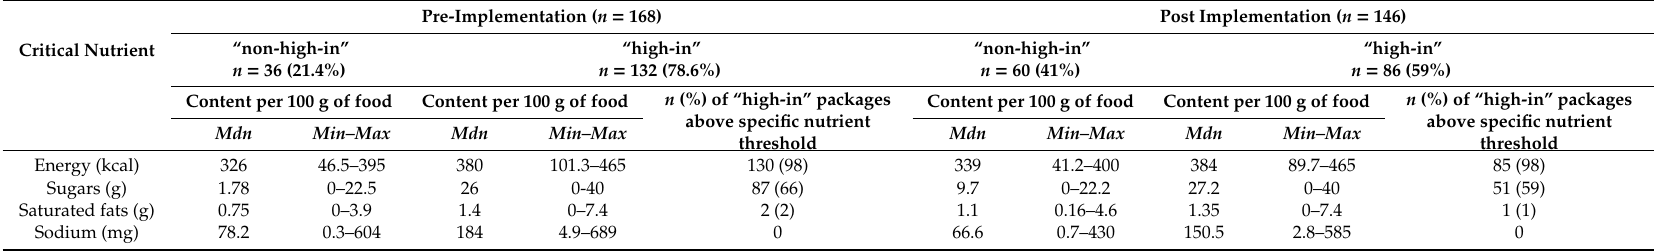
Table 2. Descriptive statistics for “high-in” and “non-high-in” breakfast cereal packages sampled pre- and post-implementation.